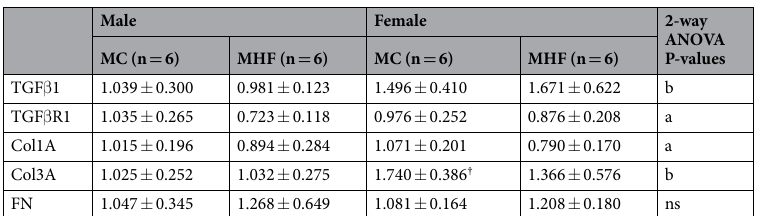
Table 4. mRNA expression of inflammatory and fibrotic markers in offspring kidney. MC (offspring of dams fed chow); MHF (offspring of dams fed high-fat diet). TGF β 1 (Transforming growth factor beta), TGF β R1 (TGF β receptor 1), Col (Collagen), FN (Fibronectin). Results are expressed as means ± SD. Data were analysed using two-way ANOVA with Bonferroni post hoc test. * P < 0.05, ** P < 0.01 (vs MC offspring), † P < 0.05 (vs male offspring). a (P < 0.05, Maternal diet effect), b (P < 0.5, Sex effect), c (P < 0.05, interaction